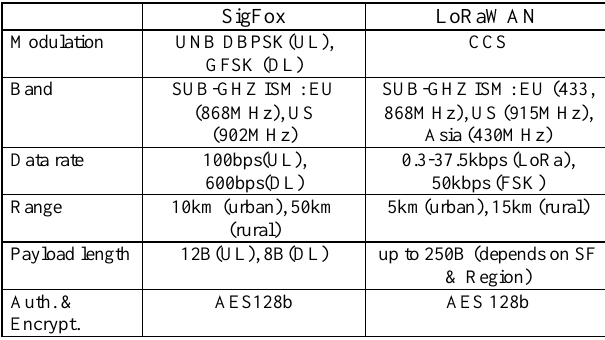
Table 1. Low Power WAN comparison: SigFox & LoRaWAN